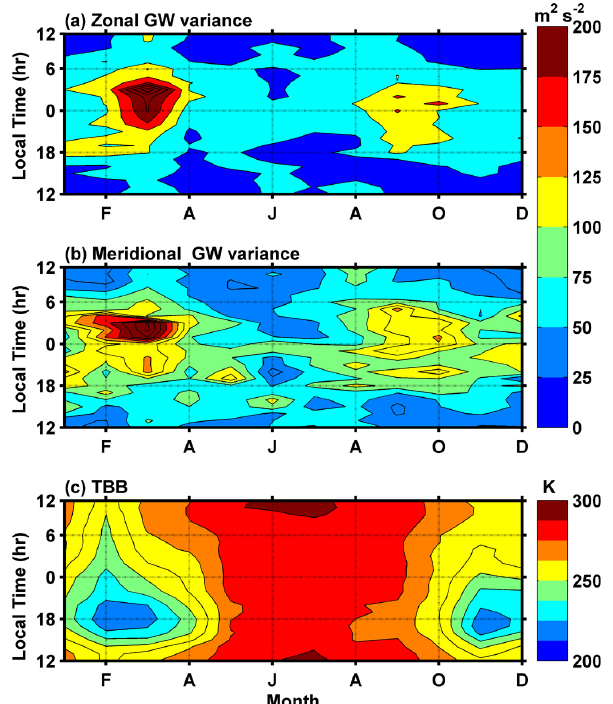
Fig. 2. Height-month contours of monthly mean values of (a) zonal component of 20–120min GW variance, (b) meridional component of 20–120min GW variance for 88km, and (c) cloud-top equivalent black body temperature